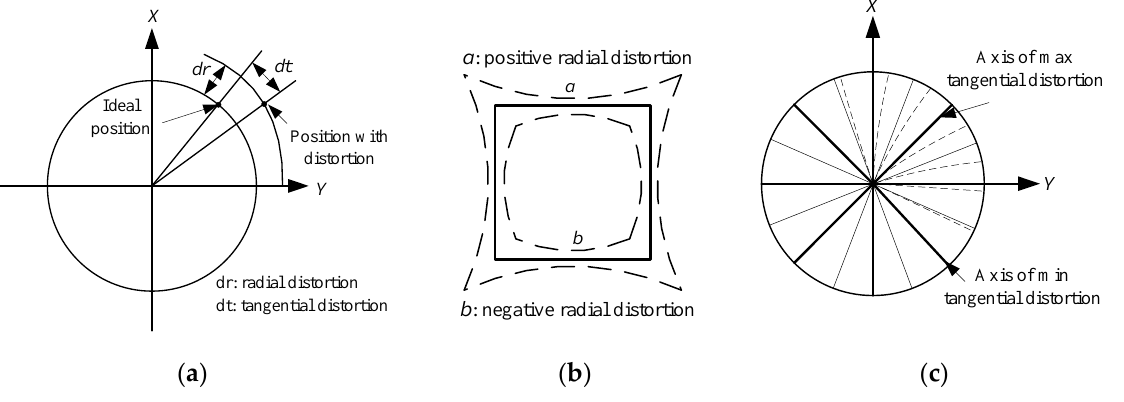
Figure 3. ( a ) Radial and tangential distortions; ( b ) Effect of radial distortion; ( c ) Effect of tangential distortion.